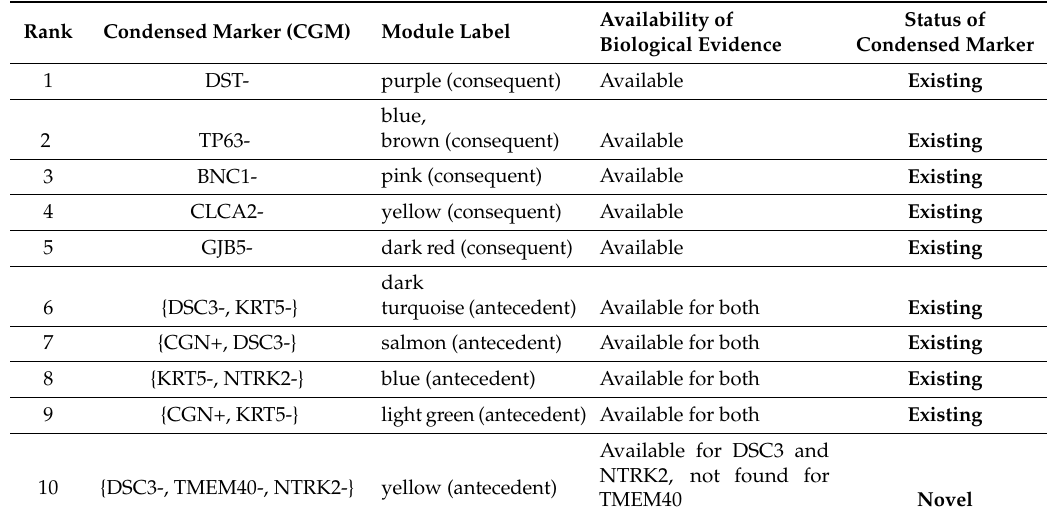
Table 1. Top ten condensed markers ( CGM s) for the lung squamous cell carcinoma (LUSC)